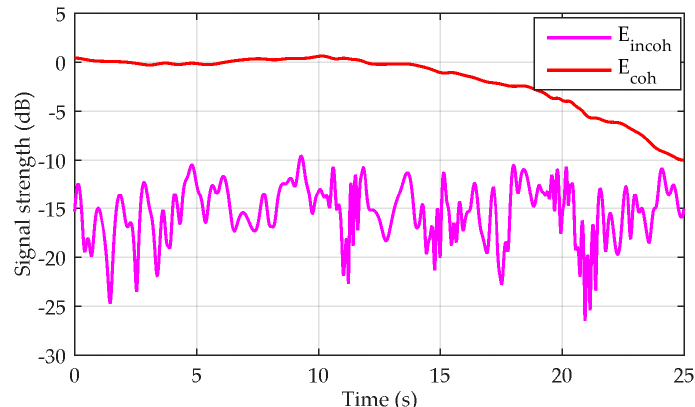
Figure 11. The coherent (red) and incoherent (magenta) scattered field as obtained inside the synthesizer. Faster changes in the incoherent scattered field result from more significant changes in the incidence direction within the particular time intervals.